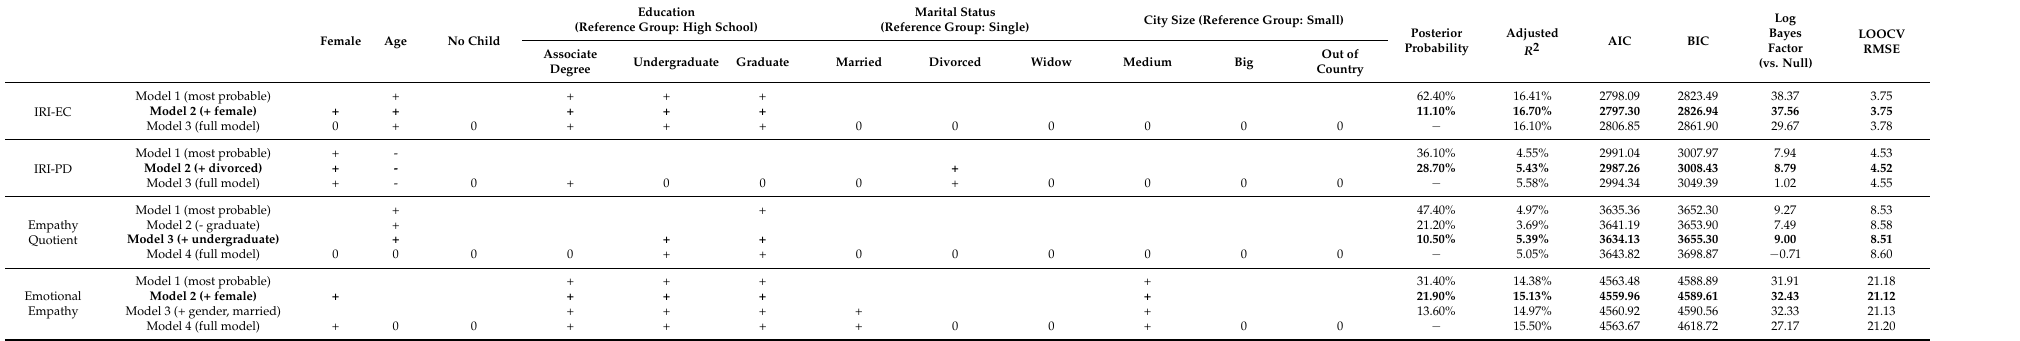
Table 2. Comparison of regression models identified by BMA (posterior probability ≥